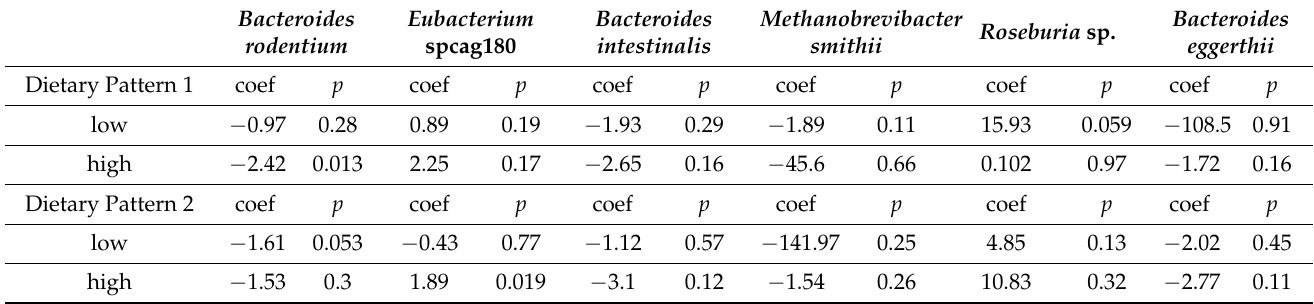
Table 3. Association analysis between taxa and BMI z-scores according to dietary pattern